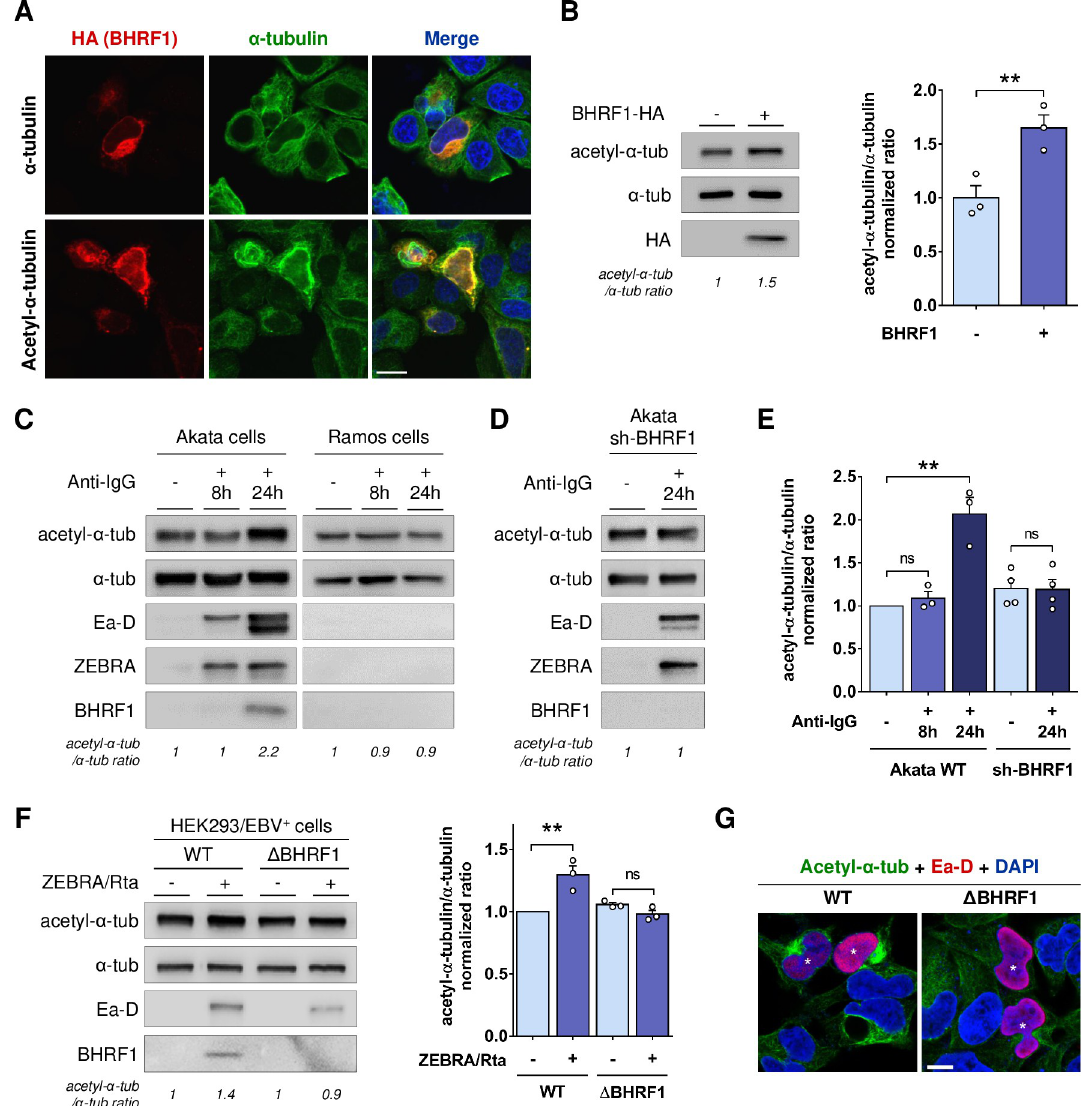
Fig 2. BHRF1 stimulates MT hyperacetylation. (A) Representative images of HeLa cells expressing BHRF1-HA and immunostained for HA and α -tubulin ( upper panel) or acetyl- α -tubulin ( lower panel ). Nuclei were stained with DAPI. Scale bar: 20 μ m. (B) Left , immunoblot analysis of acetyl and total α -tubulin in BHRF1-HA-transfected HeLa cells. Right , normalized ratios of acetyl- α -tubulin to total α -tubulin. (C) Immunoblot analysis of acetyl- α -tubulin, α -tubulin, Ea-D, ZEBRA and BHRF1 in the Akata and Ramos cells treated or not with anti-human IgG for 8 h or 24 h to induce EBV reactivation. (D) Immunoblot analysis of acetyl- α -tubulin, α - tubulin, Ea-D, ZEBRA and BHRF1 in Akata cells deficient for BHRF1 expression (sh-BHRF1). (E) Normalized ratios of acetyl- α - tubulin to α -tubulin in Akata cells. (F-G) EBV WT or EBV Δ BHRF1 were reactivated in HEK293 cells by transfection with ZEBRA and Rta plasmids for 24 h. (F) Left , immunoblot analysis of acetyl- α -tubulin, α -tubulin, Ea-D and BHRF1. Right , normalized ratios of acetyl- α -tubulin to α -tubulin. (G) Confocal images of HEK293/EBV+ cells immunostained for acetyl- α -tubulin and Ea-D. Nuclei were stained with DAPI. Scale bar: 20 μ m. Stars indicate EBV-reactivated cells. Data represent the mean ± SEM of three independent experiments. ns = non-significant; �� P < 0.01 (Student’s t-test). https://doi.org/10.1371/journal.ppat.1010371.g002 24h after EBV reactivation in Akata cells (visualized by Ea-D and ZEBRA viral protein expres- sion). This MT hyperacetylation coincided with BHRF1 expression. We confirmed that BHRF1 is required for this phenotype in the context of EBV infection of B cells, using an shRNA targeting BHRF1 ( Fig 2D and 2E ). In parallel, in HEK293/EBV+ epithelial cells, the